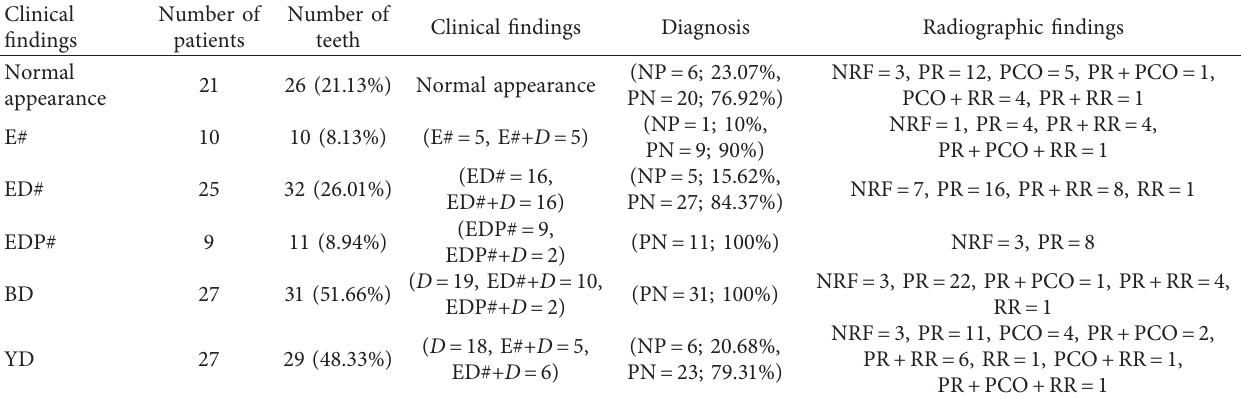
Table 5: Distribution of clinical findings.